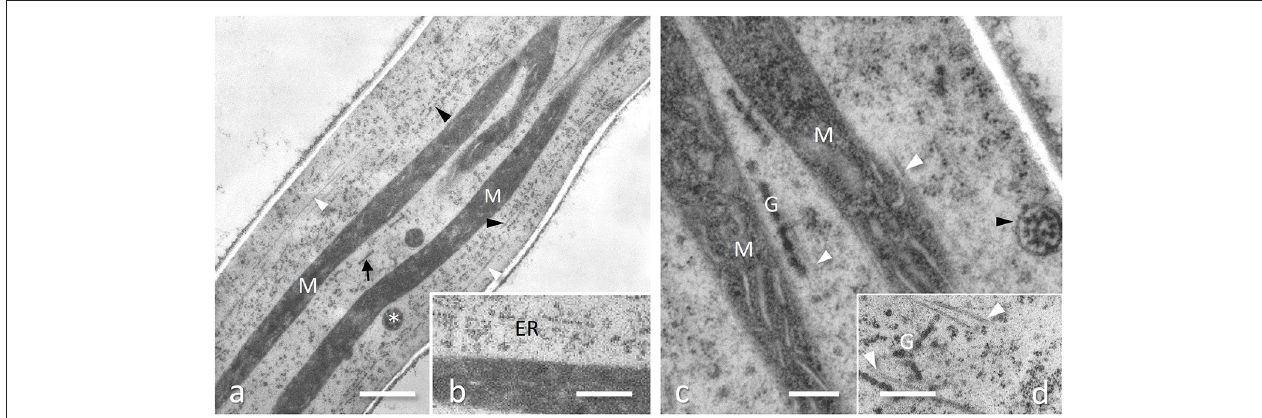
FIGURE 2 | Subapical region of Tuber melanosporum hyphae, Ascomycota, cryofixed and freeze substituted. (a) Numerous very elongated mitochondria (M) running along to the longitudinal axis of the hyphae, together with a well-developed ER (black arrowheads), numerous microtubules (white arrowheads) and sausage-like strings of Golgi cisternae (arrow). Bar, 1.0 µ m. (b) Enlargement of the ER in Figure 5 . Bar, 0.5 µ m. (c) Mitochondria (M) showing flat cristae, in close association with microtubules (white arrowhead) and Golgi (G), whose secretory vesicles may be enclosed in membrane-bound multi-vesicular bodies (black arrowhead) for a faster delivery to hyphae tip; from Amicucci et al., with permission of the publisher. Bar, 0.2 µ m. (d) Ramified cisternae string of Golgi (G) among microtubules (white arrowheads). Bar, 0.5 µ